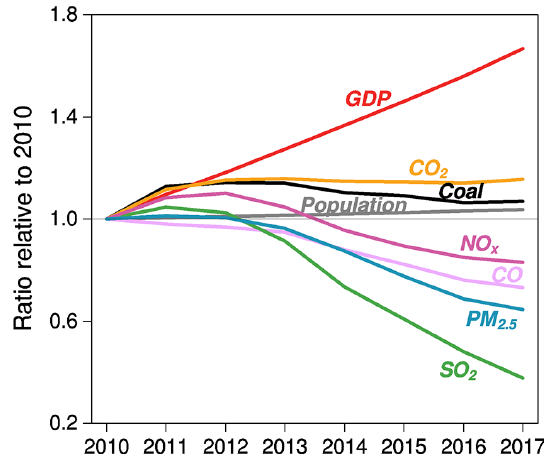
Figure 2. Emission trends and underlying social and economic fac- tors. The coal usage is achieved from Chinese Energy Statistics (Na- tional Bureau of Statistics, 2018a, b). The GDP and population data come from the National Bureau of Statistics (2018b, c). Data are normalized by dividing the value of each year by their correspond- ing value in